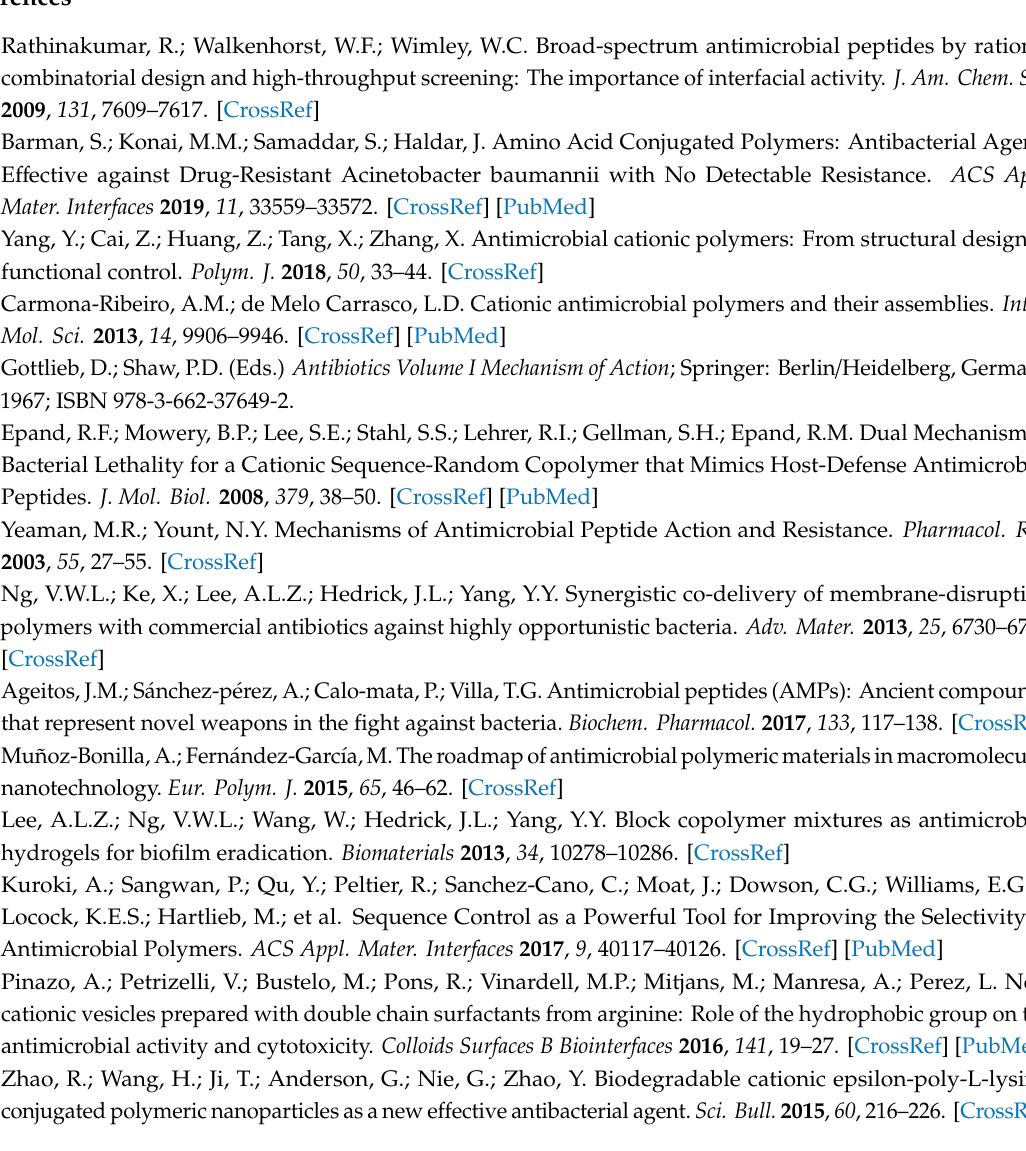
Figure S1: 1 H NMR spectra of serinol (a), Boc-serinol (b) and TBODC(c)(DMSO- d 6 , 400 MHz); Figure S2. 13 C NMR spectrum of TBODC (DMSO- d 6 , 100 MHz); Figure S3. Investigation of copolymerization time of TBODC and CL; Figure S4. 1 H NMR spectra of P(CL- ran -TBODC 50.9%) after deprotection for certain